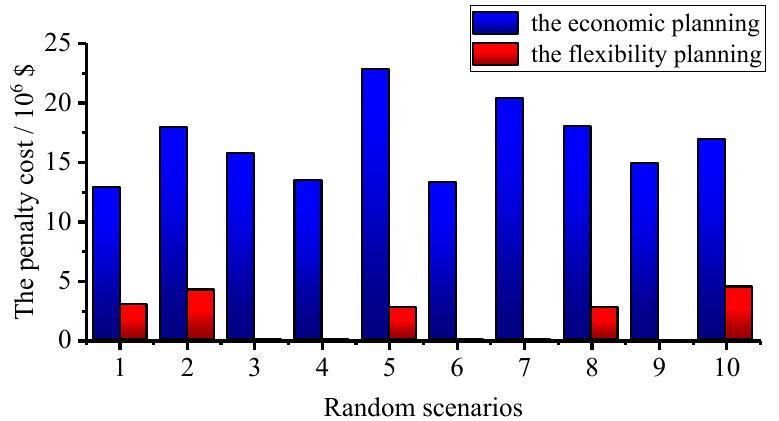
Figure 6. The renewable energy abandoned penalty costs in random scenarios.